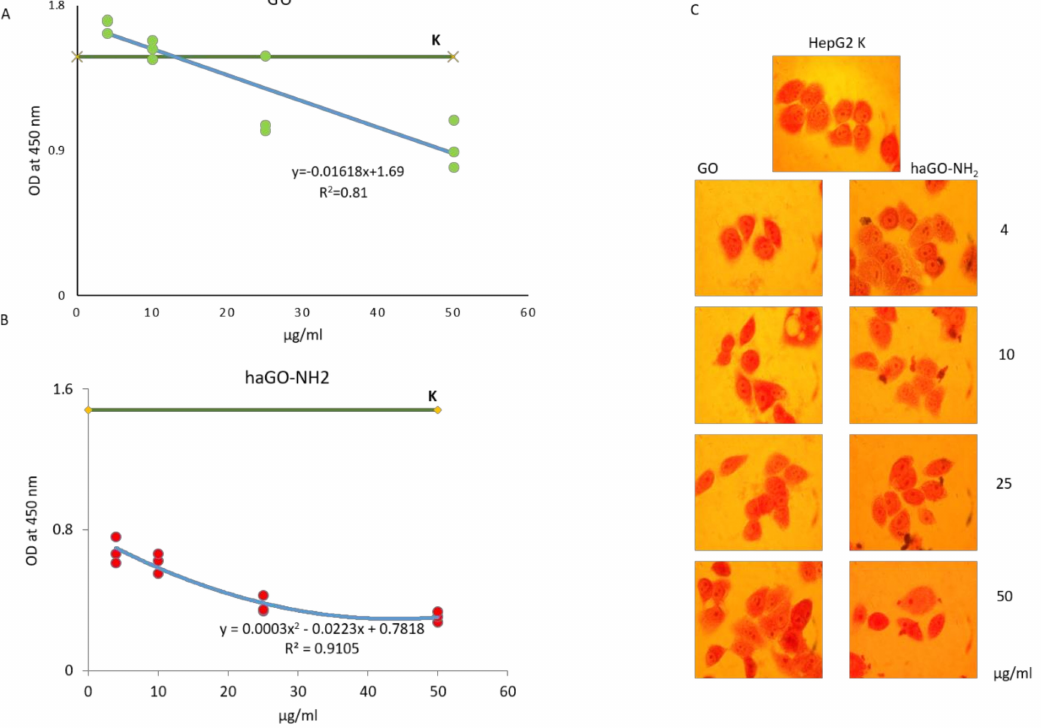
Figure 3. Cell viability and morphology of HepG2 cells treated for 24 h with GO and haGO-NH 2 . ( A , B ) WST-8 (Sigma-Aldrich Co.) was used to evaluate cell viability - linear regression models for both types of GO NPs cytotoxic e ff ect on HepG2 cells. ( C ) A panel of micrographs with neutral red stained HepG2 cells taken under phase contrast microscopy after 24 h of incubation of the cells with di ff erent concentrations of GO and haGO-NH 2 . Magnification 25 ×